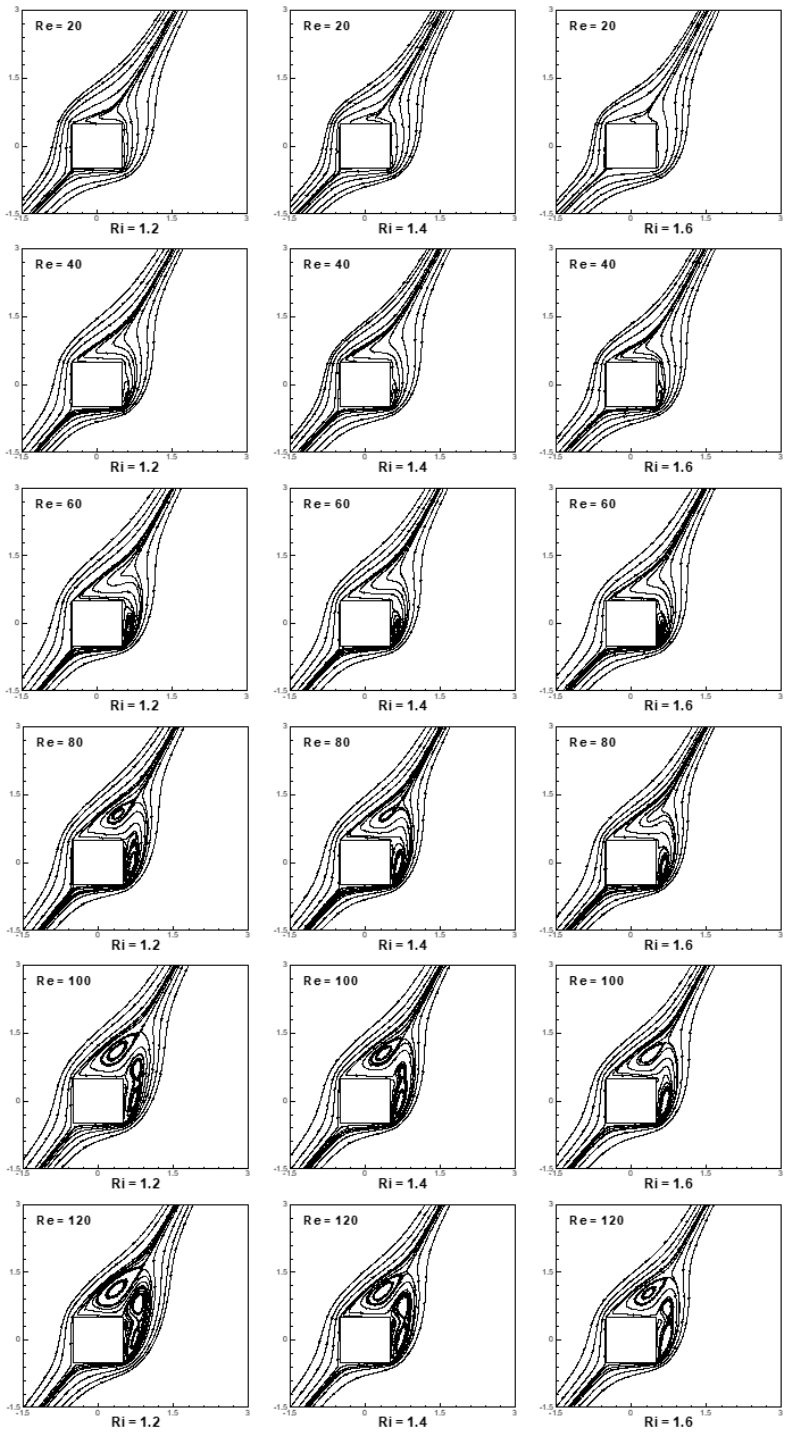
Figure 9. Steady state streamline patterns at ( α = 30 ◦ , 20 ≤ Re ≤ 120 and 1.2 ≤ Ri ≤